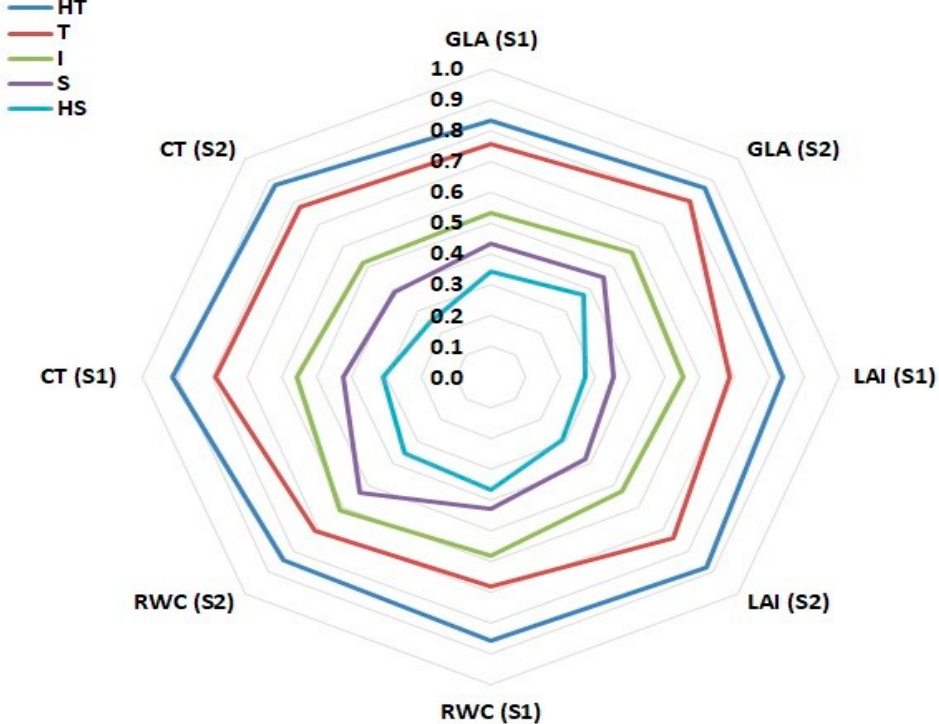
Figure 5. Radar charts comparing four traits of the five groups. Data were analyzed using least squares (LS) in two seasons. Relative water content (RWC), canopy temperature (CT), leaf area index (LAI), and green leaf area (GLA).